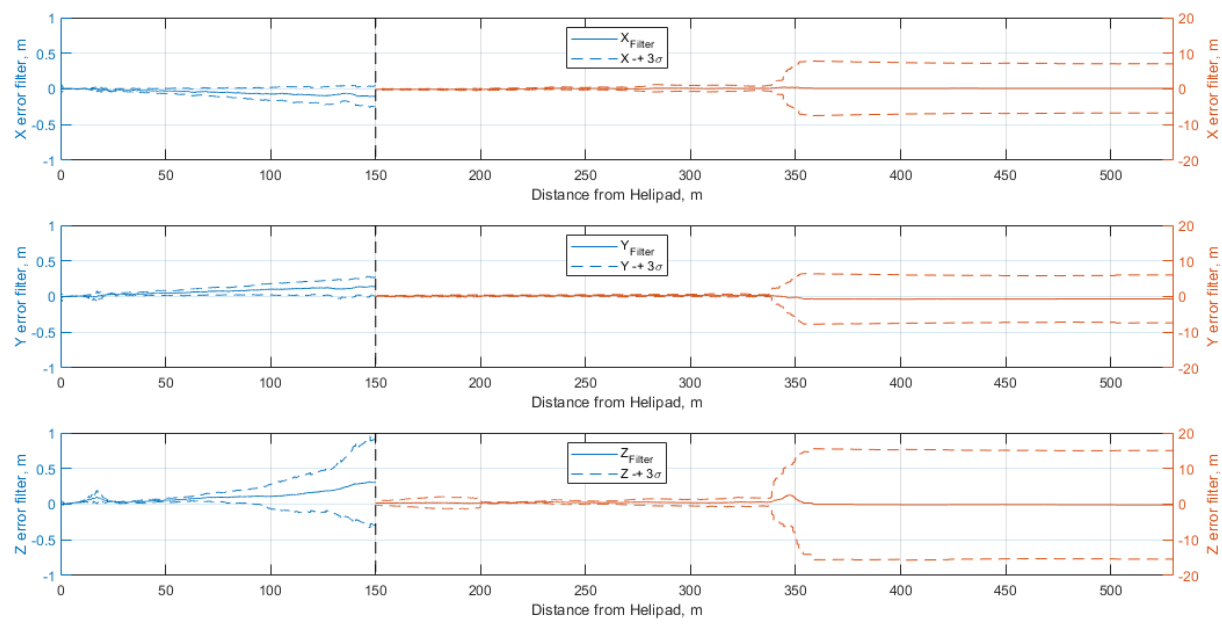
Figure 12. EKF position estimates errors average over 50 simulations and 3 − sigma bounds.